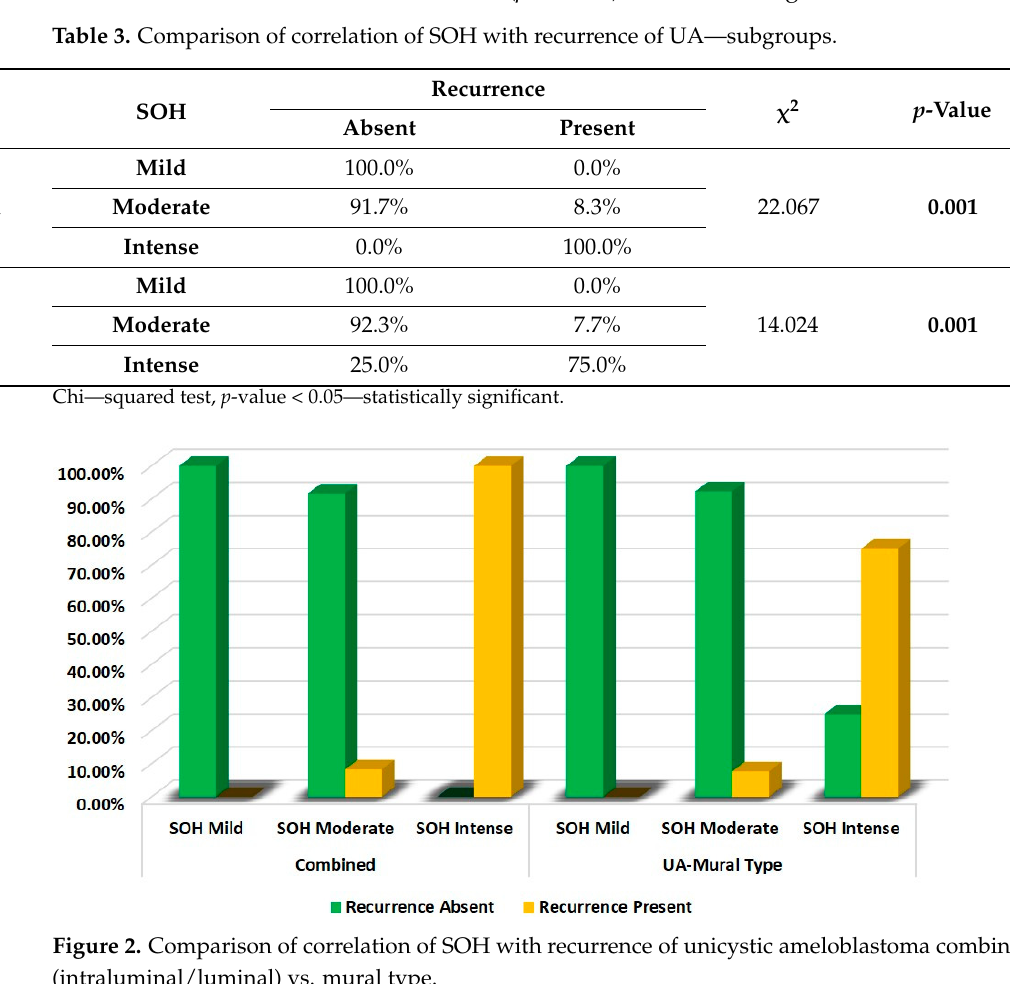
Table 4. Comparison of correlation of clinical parameter with recurrence of unicystic ameloblas- toma—UA-mural type. Clinical Parameters